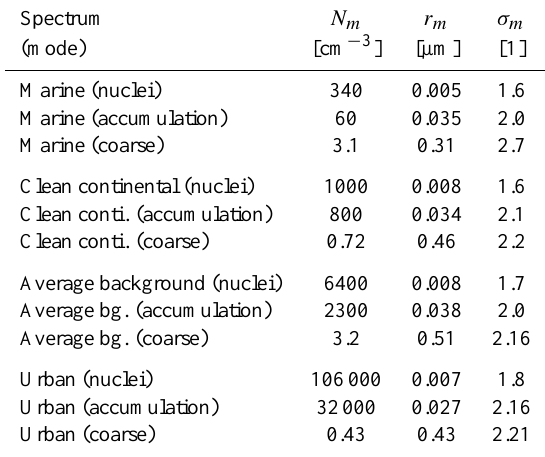
Table 2. Aerosol distributions used in the model runs presented